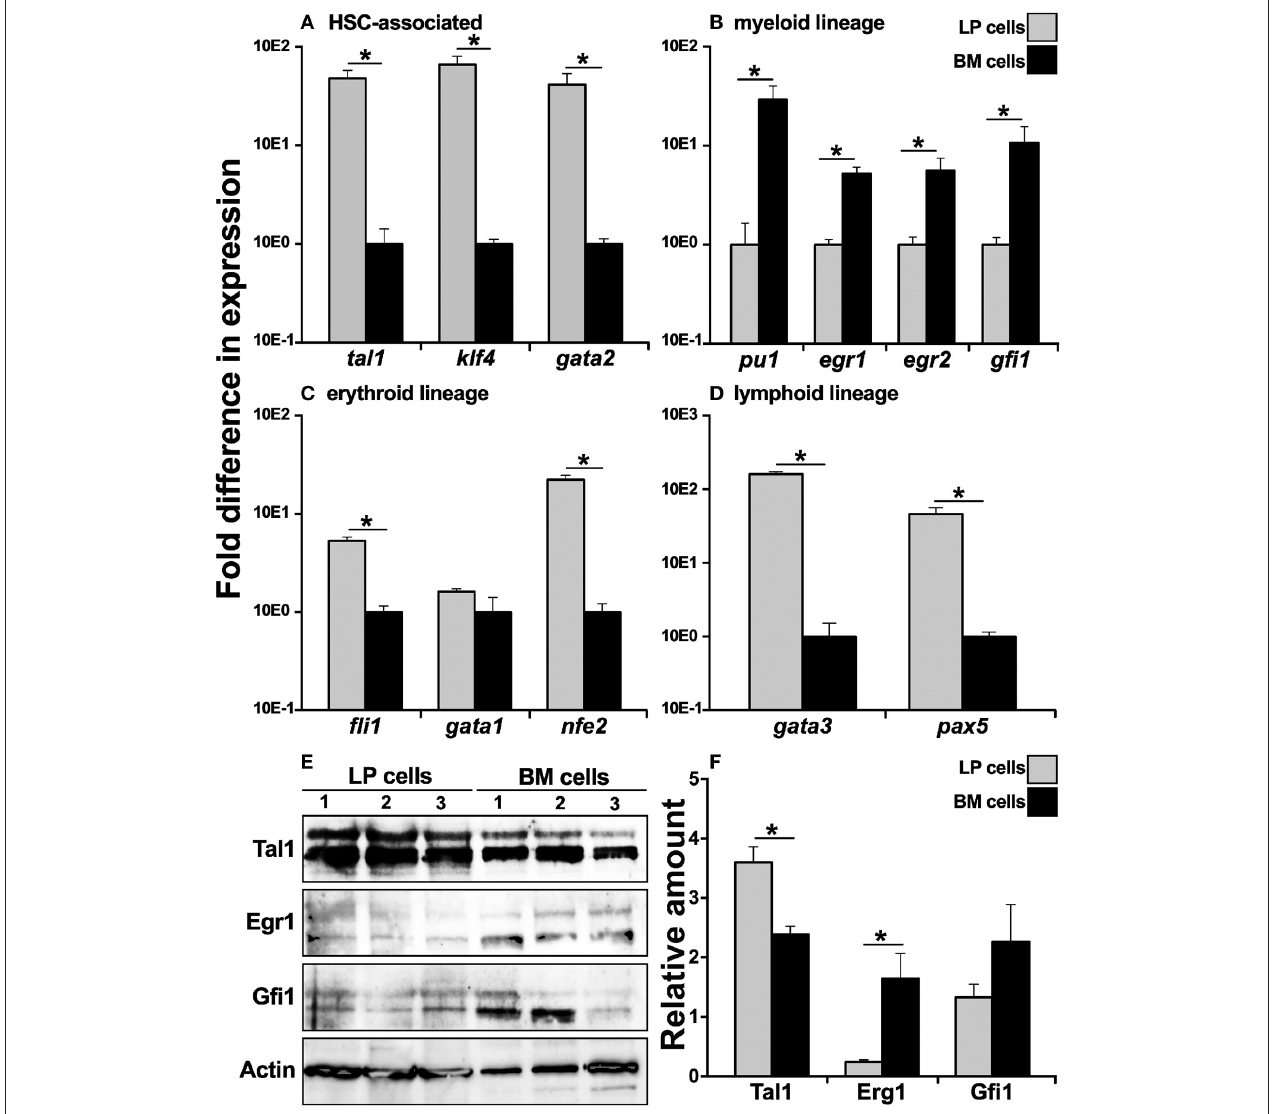
FIGURE 1 | Analysis of lineage-specific transcription factor gene expression in X. laevis liver periphery and bone marrow cells. X. laevis liver periphery and bone marrow cells were isolated and examined by qPCR for their expression of (A) HSC-associated, (B) myeloid lineage, (C) erythroid-lineage, and (D) lymphoid-lineage transcription factor genes. All gene expressions were quantified relative to the gapdh endogenous control and normalized against the lowest observed expression. 30 µ g of total cell lysate proteins from LP and BM cells was used for western blot analysis to determine the protein levels of (E) Tal1, Egr1, and Gfi1 with beta actin as a loading control. The protein levels were quantified by (F) densitometry analyses using ImageJ software. Results are means ± SEM ( A–D : N = 5; E,F : N = 3) and asterisk overhead of horizontal lines denotes statistical significance, P < 0.05.